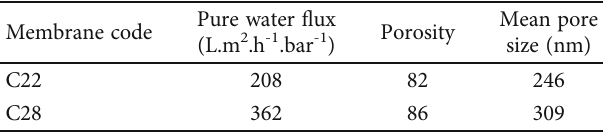
Table 5: The e ff ect of the coagulation bath temperature on the pure water fl ux, porosity, and mean pore size of PAN hollow fi ber membrane (C22: 22 ° C, C28: 28 °